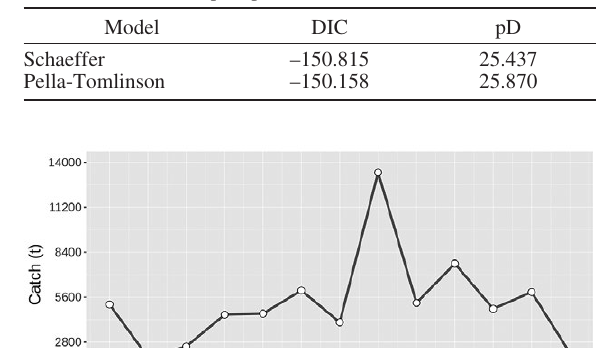
Table 2. – Deviance information criteria (DIC) and effective num- ber of estimated parameters (pD) for the Bayesian state-space sur-